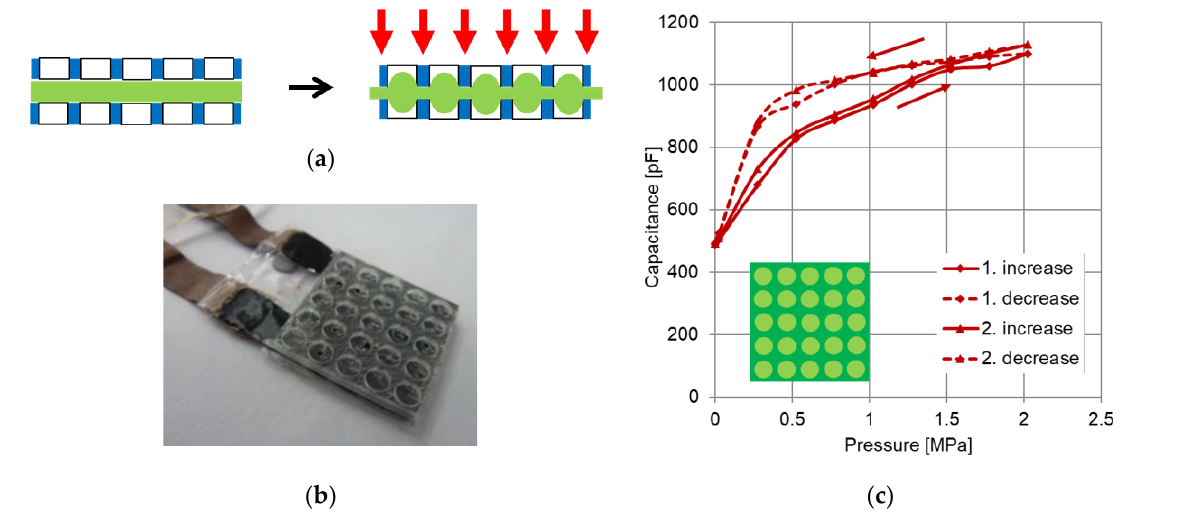
Figure 4. Scheme of the bulging of a dielectric elastomer pressure sensor with soft plates with openings ( a ), photograph of the pressure sensor ( b ) and measured capacitance upon increase and decrease in pressure in two cycles ( c ) [97].